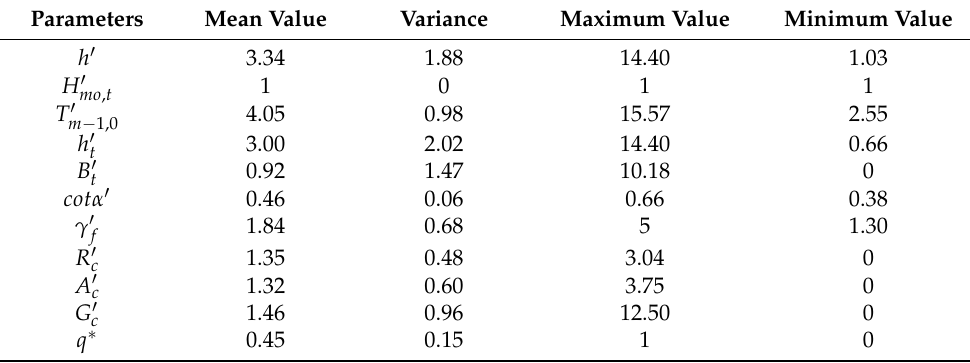
Table 1. Distribution characteristics of input parameter data of the training set. Figure 5. Parameters of straight slopes [27].